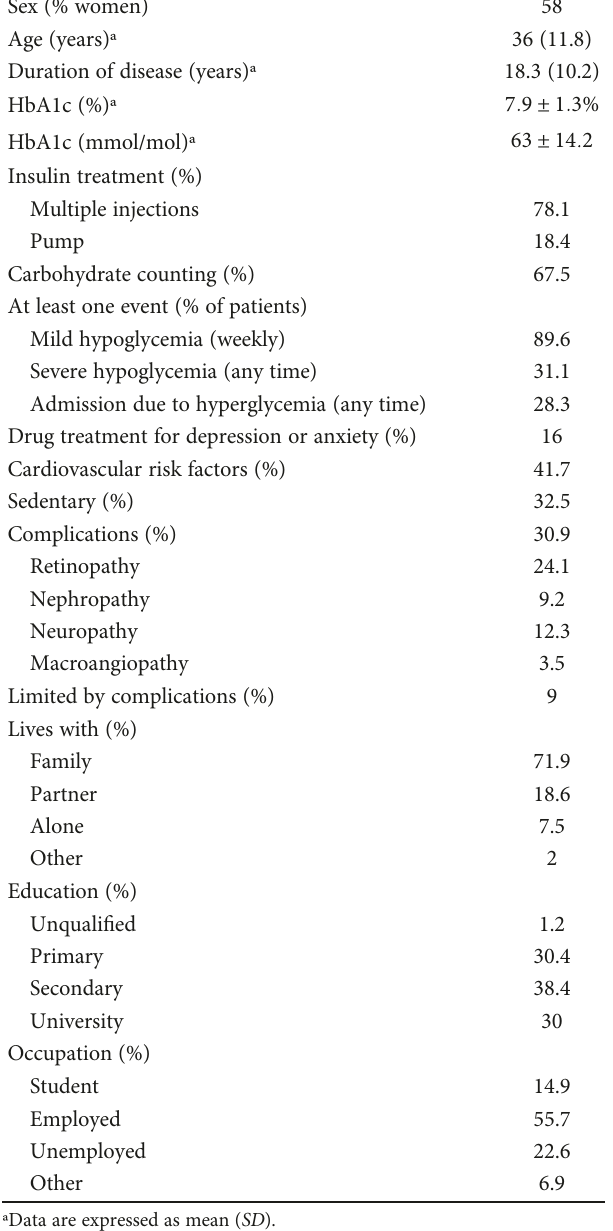
Table 1: Participants ’ characteristics. N = 428